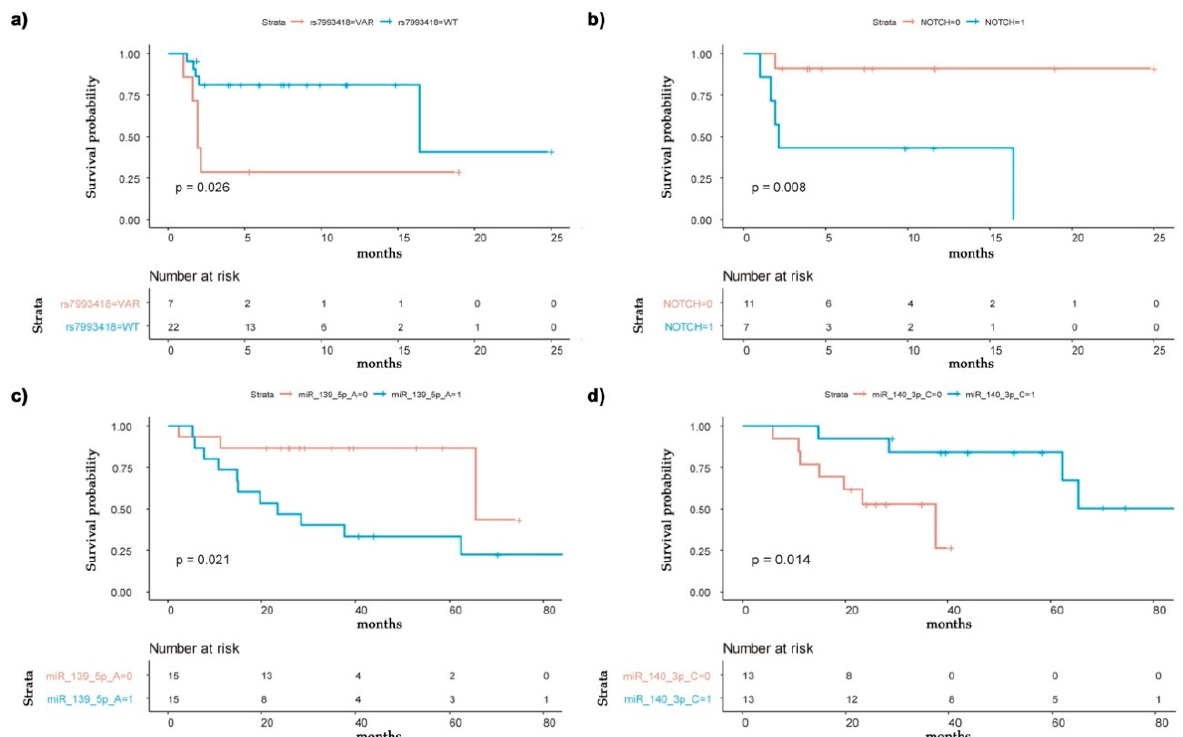
Figure 9. Biomarkers’ association with progression-free survival and overall survival. Association of the studied biomarkers with progression-free survival and overall survival with regorafenib treatment. Kaplan–Meier curves were calculated with the associated log-rank test analysis to determine which biomarkers were related to survival parameters and disease progression. ( a ) rs7993418 is significantly associated with disease progression. ( b ) Notch expression is significantly associated with disease progression. ( c ) High miR-139-5p values are correlated with more prolonged overall survival. ( d ) Low miR-140-3p values are correlated with more prolonged overall survival. The median value of each miRNA has been used to distribute high and low miRNA values.